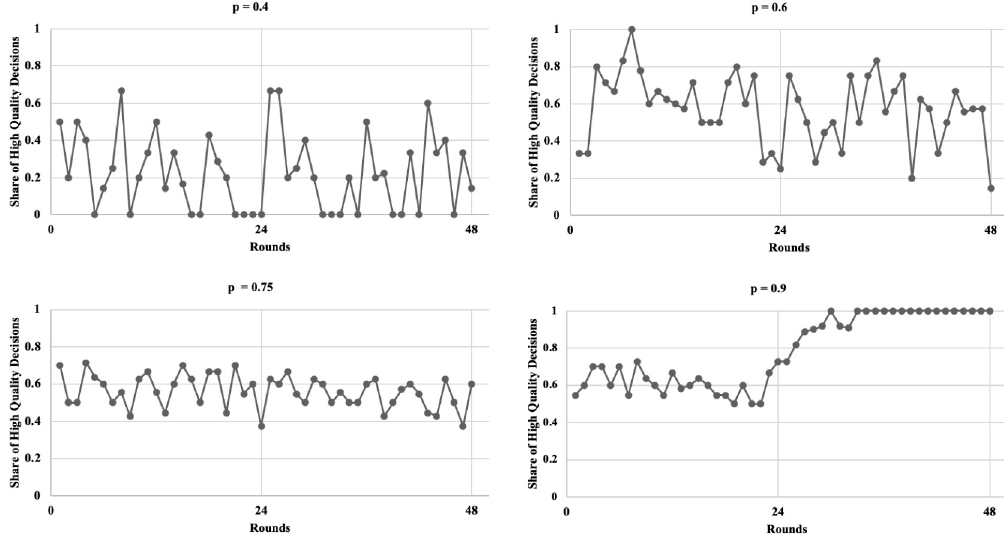
Fig 3. Share of high-quality decisions (unrealistic deadlines only) depending on the probability of facing an unrealistic deadline.